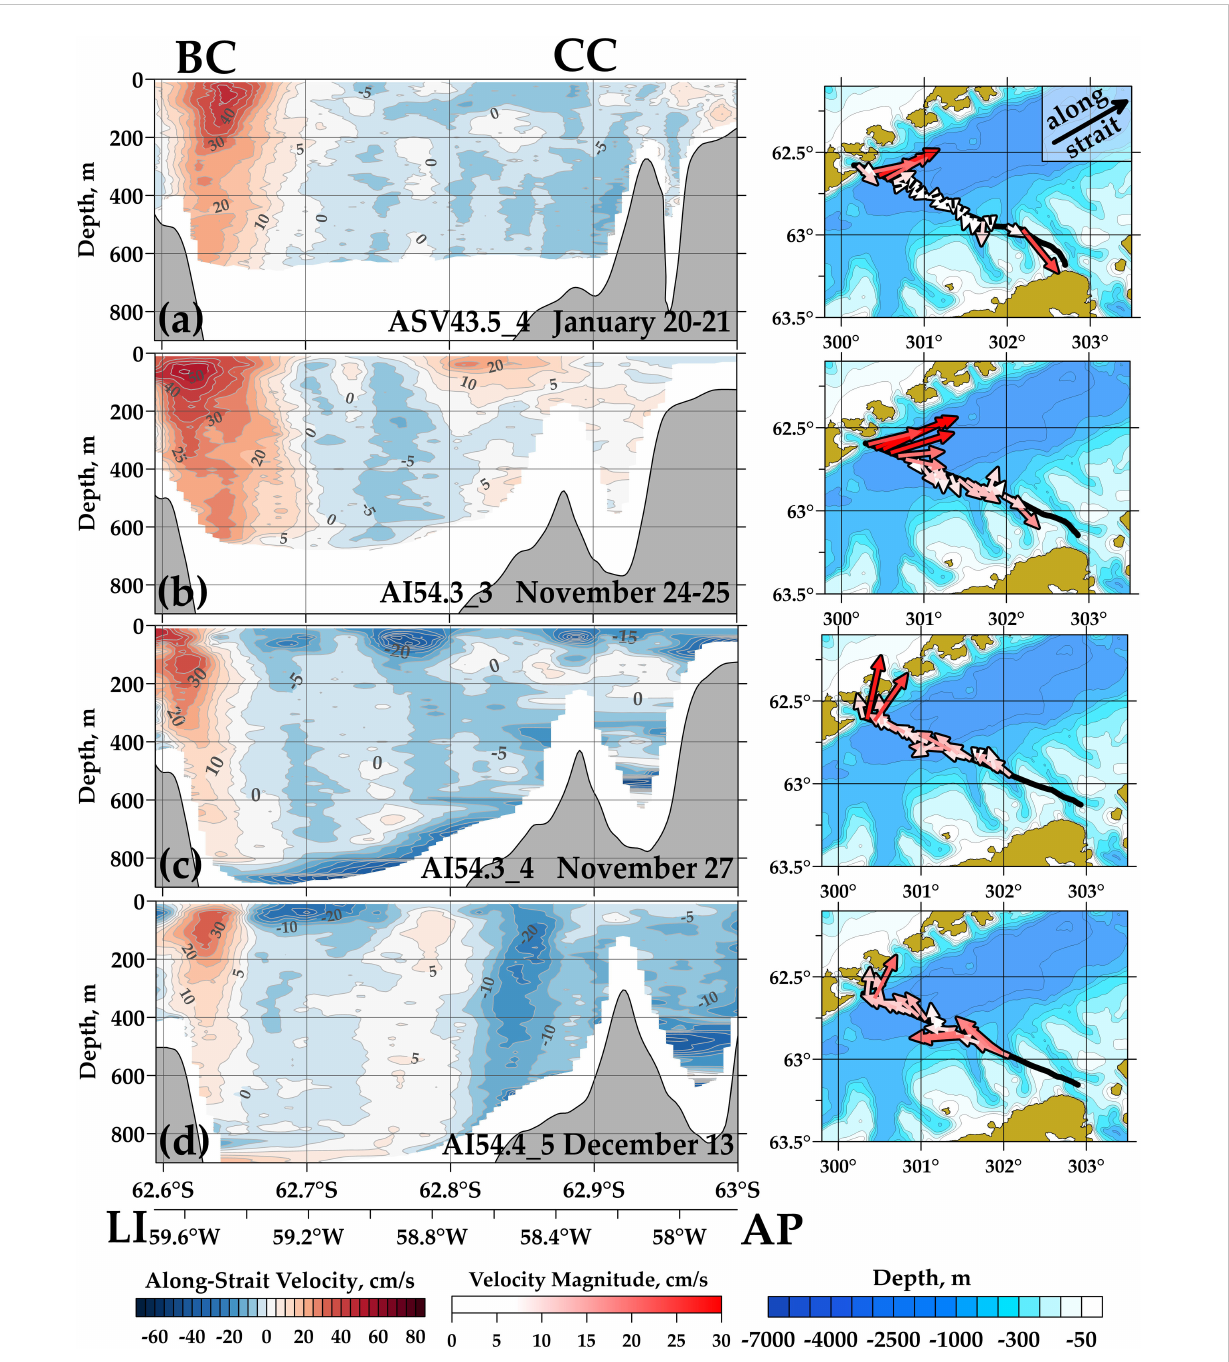
FIGURE 6 Along-strait velocity distributions at four crossings between Livingston Island (LI) and Antarctic Peninsula (AP) performed on January 20-21 (A) , November 24-25 (B) , November 27 (C) , and December 13 (D) . The measurements were performed from the R/V ASV (A) and R/V AI (B – D) . Positive values of velocity correspond to the east-north-east direction (the exact value is 60° relative to the north; this direction is shown by black arrow in the upper right panel). The velocities were projected to the direction along the strait independently on the orientation of transects. Locations of the crossings are shown in the right panels together with the depth-averaged SADCP velocities. The ocean bottom is shown by grey color. LI, Livingston Island; AP, Antarctic Peninsula; BC, Brans fi eld Current; CC, Antarctic Coastal